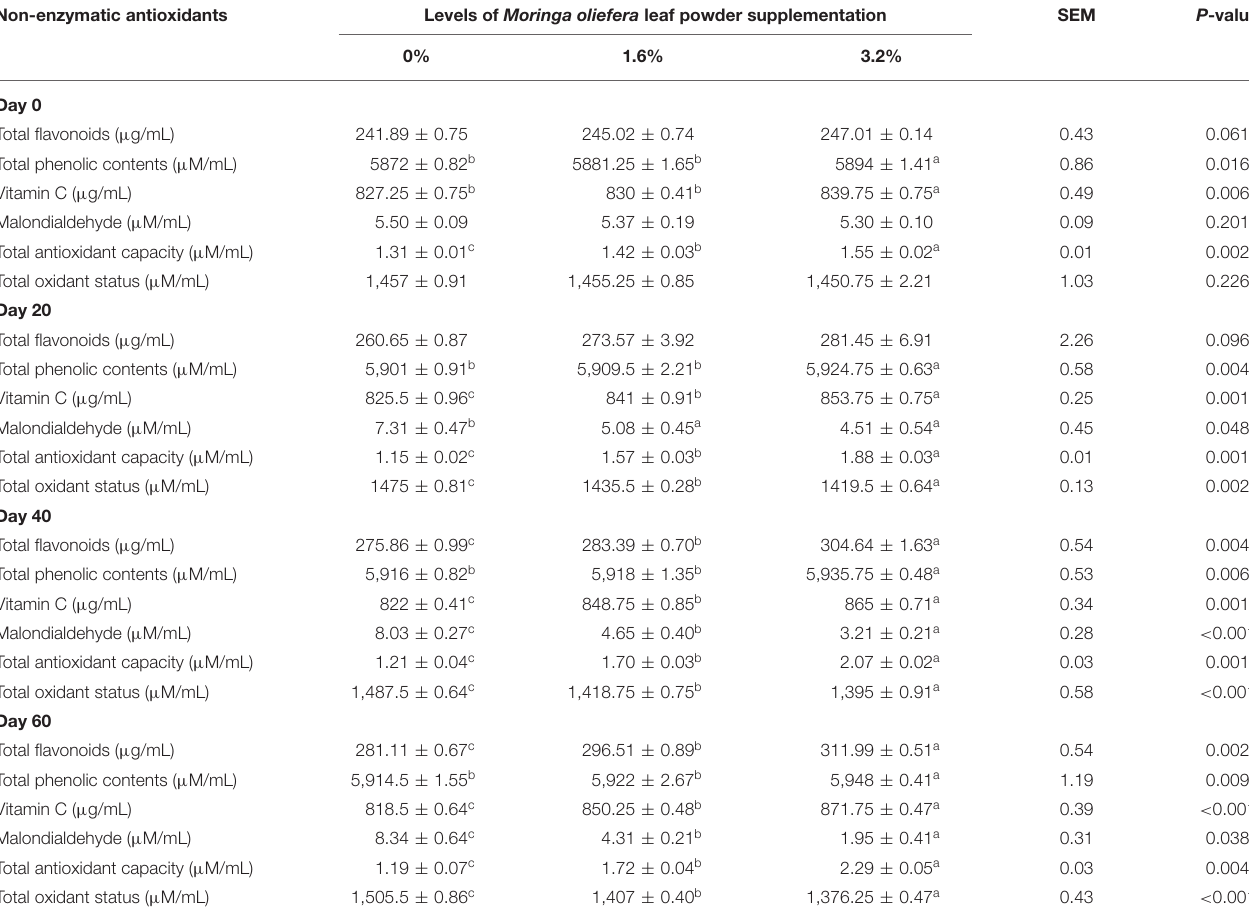
TABLE 4 | Plasma non-enzymatic antioxidant indices of pregnant beetal goats. Non-enzymatic antioxidants Levels of Moringa oliefera leaf powder